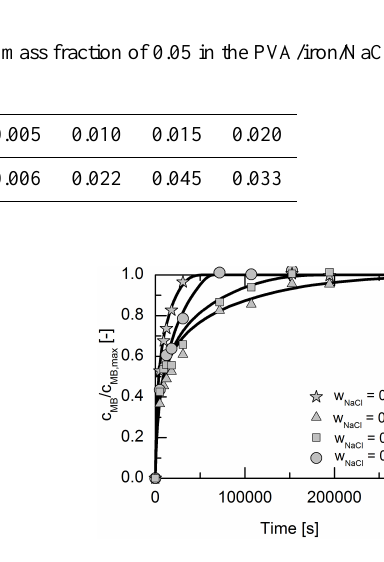
Figure 7. MB concentration profiles in the PVA/iron/NaCl com- posite films of 180µm thickness at 80% RH, a NaCl mass fraction of 0.01 and iron mass fractions of 0.01, 0.02, and 0.06 at 313.15K (a) , and iron mass fractions of 0.015 and 0.06 at 298.15K (b) . Sym- bols represent experimental data and the lines are the modeled MB concentration profiles in the absence of iron and NaCl.